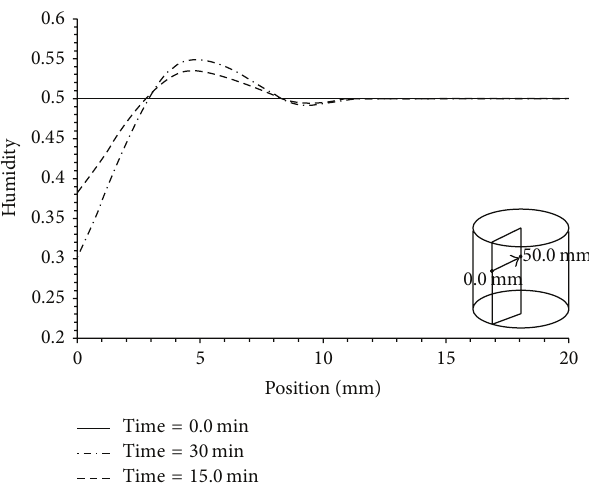
Figure 9: Humidity versus radial position.